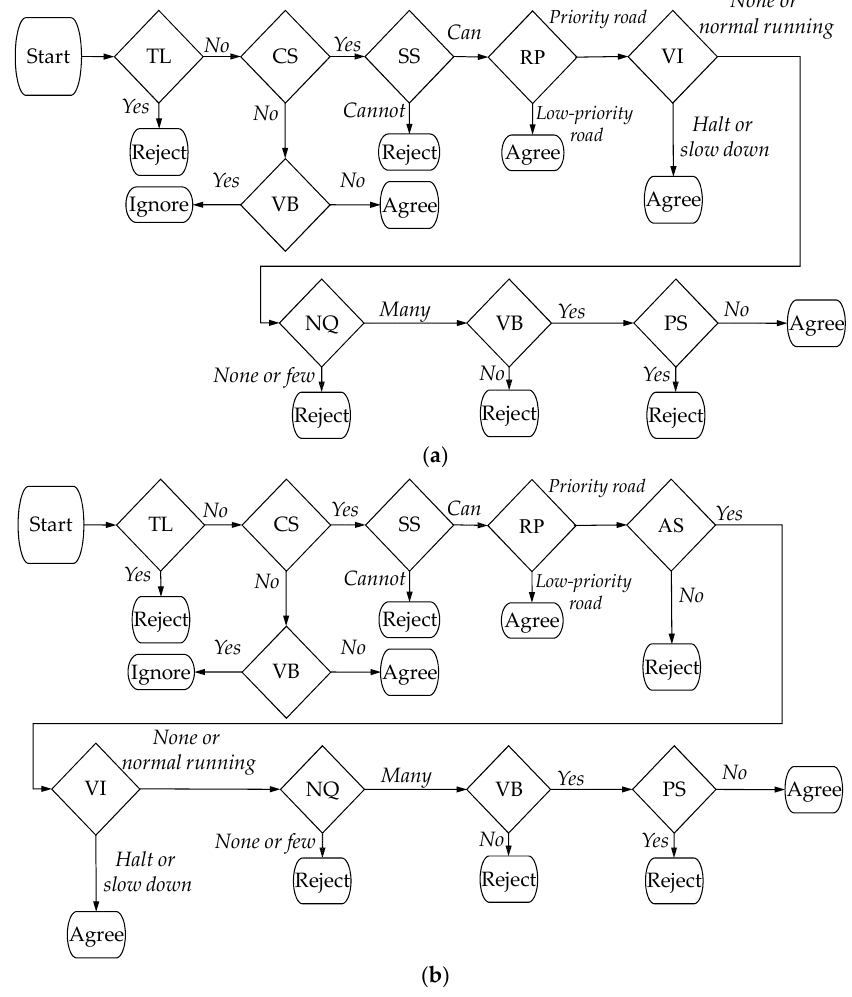
Figure 4. Yielding decision flow. TL: Traffic light; CS: Conflict situation; SS: Stop safely; RP: Road priority; VI: Vehicle beyond the intersection; VB: Vehicle in the back; NQ: Number of queuing vehicles; PS: Pedestrians in the surroundings; AS: Availability of enough space. (a) Patterns 1 and 4; (b) patterns 2 and 3.